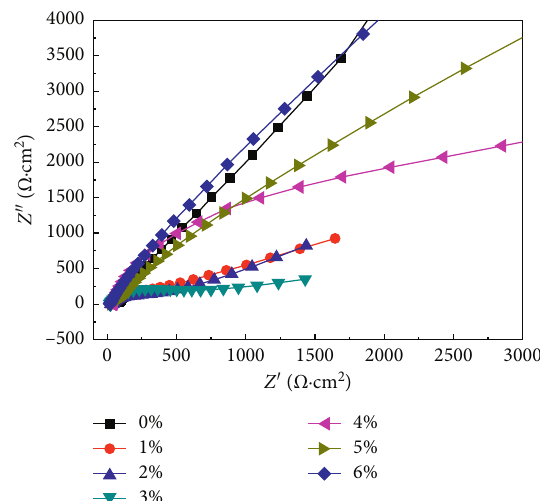
Figure 8: Nyquist plot of the laser-cladding coating with different CeO 2 contents in 3.5% NaCl solution.